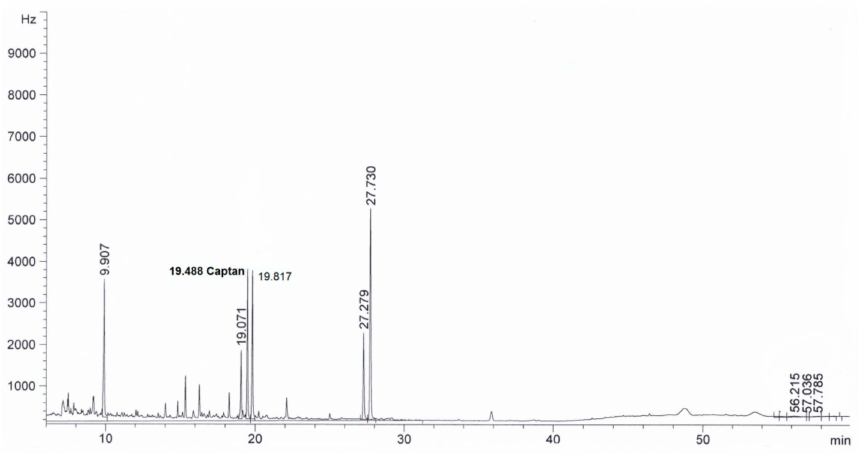
Figure 4. The chromatogram (GC- µ ECD) of industrial wastewater with the clean-up step using the dSPE (0.15 g SiO 2 ).